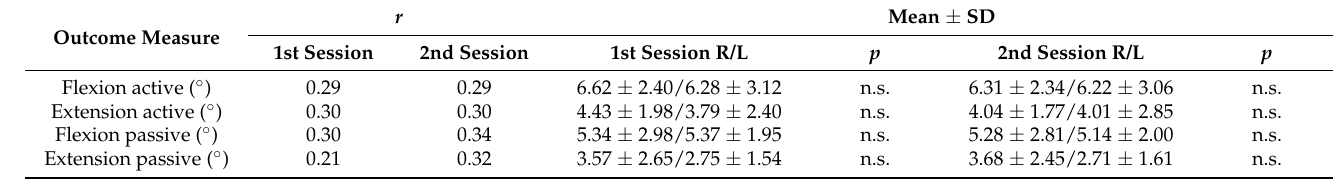
Table 3. Agreement between right and left side mean joint position sense (JPS) angle